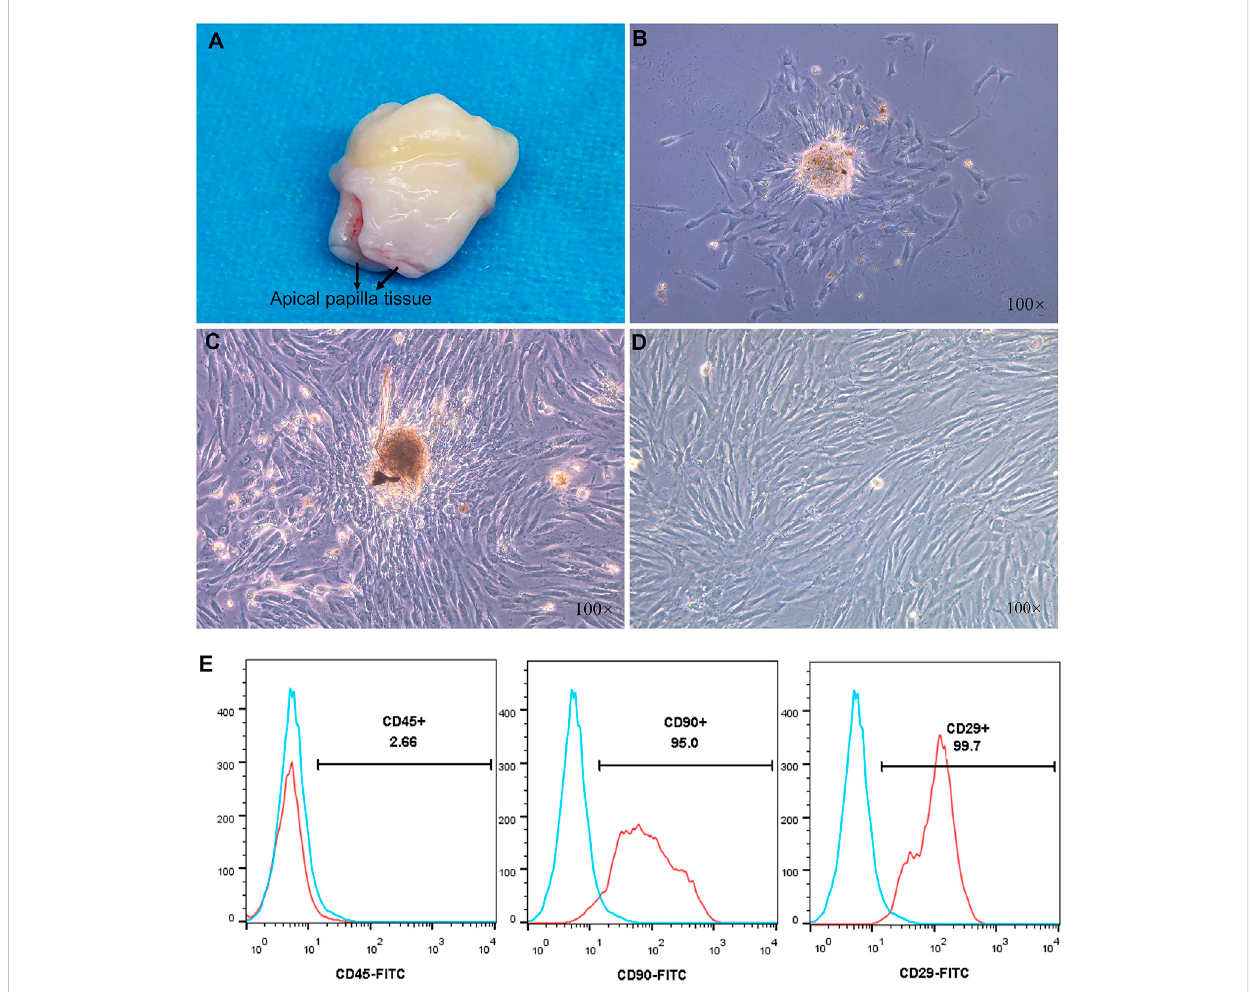
FIGURE 4 (A) Third molars with papilla (B,C) Morphology of primary cultured human stem cells from the apical papilla (SCAPs) at 3 and 7 days (D) The third generation SCAPs cells (E) Histogram analysis of cell surface markers, the SCAPs expressed a high degree of CD29 and CD90 as mesenchymal stem cell markers but a low degree of CD45 as hematopoietic stem cell